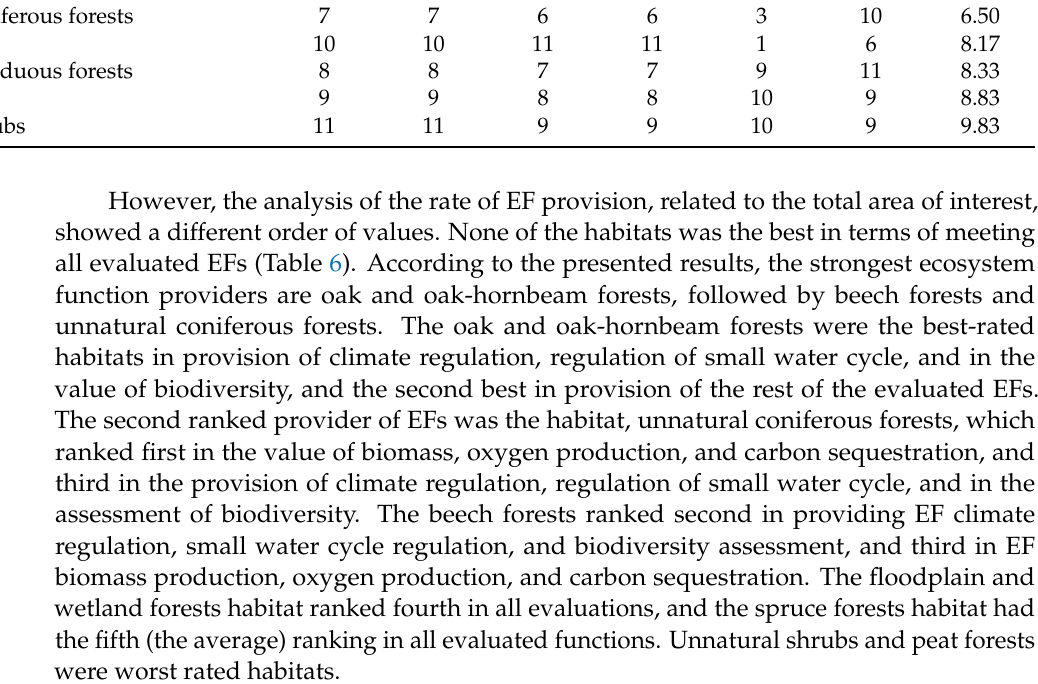
Table 6. Ranking of forest habitats, by importance in ecosystem function provision, considering their total area. Habitat